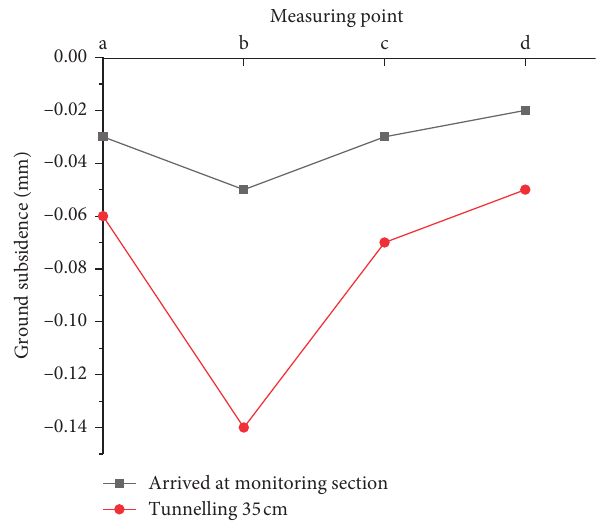
Figure 18: Surface settlement curve.